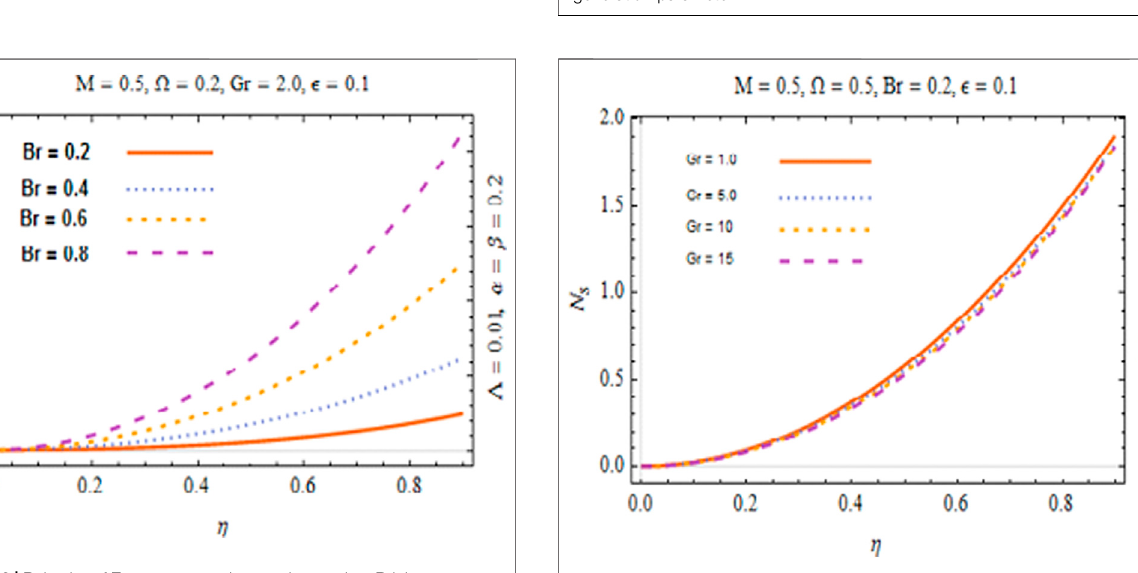
FIGURE 17 | Behavior of Entropy generation number against heat generation parameter.